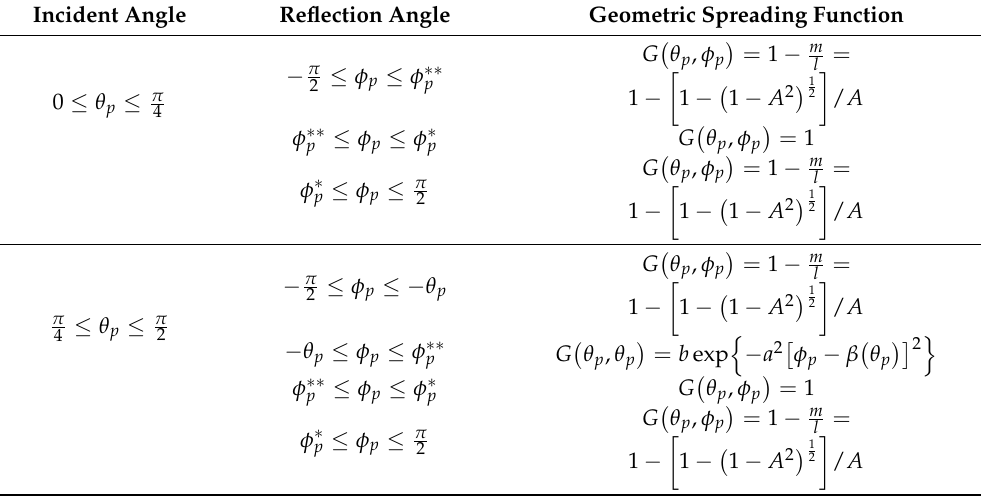
Table 4. Geometric spreading function expression for the wide adaptability Torrance–Sparrow model.